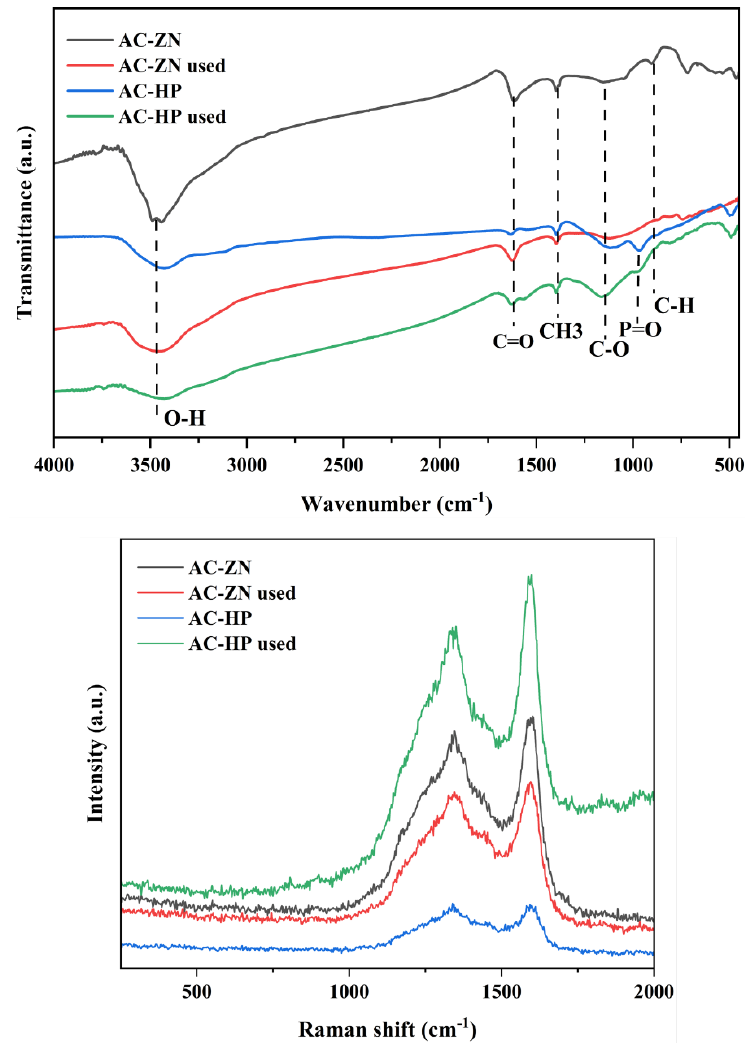
Figure 2. FT-IR spectra and Raman spectra of AC-ZN and AC-HP.